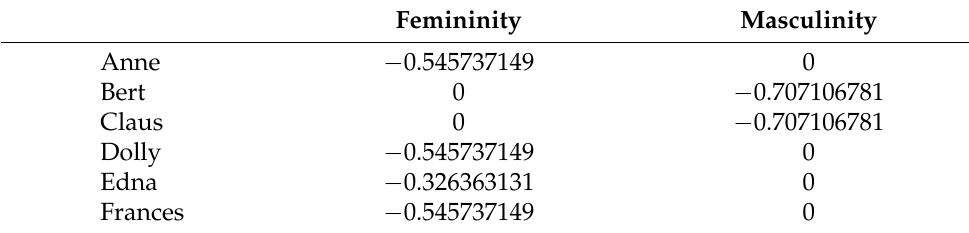
Table 6. Loading matrix A with the DisjointTuckerALS algorithm for behavioral level data.